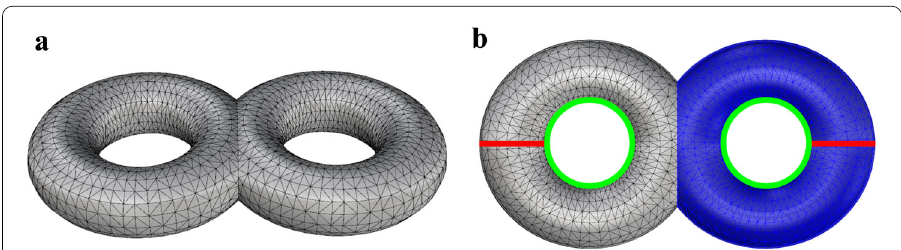
Fig. 3 Topological properties and pants decomposition of a double torus. a Triangulated genus-2 surface without boundaries has Eulercharacteristic χ = 2 − 2 g − b = − 2. b Pants decomposition provides two pants (gray and blue meshes) by cutting along handle loops and using symmetry. Homology basis is composed by two handle loops and two tunnel loops respectively depicted in red and green